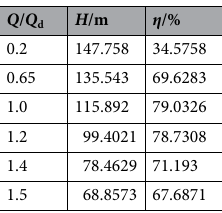
Table 3. Predicted hydraulic performance values of the